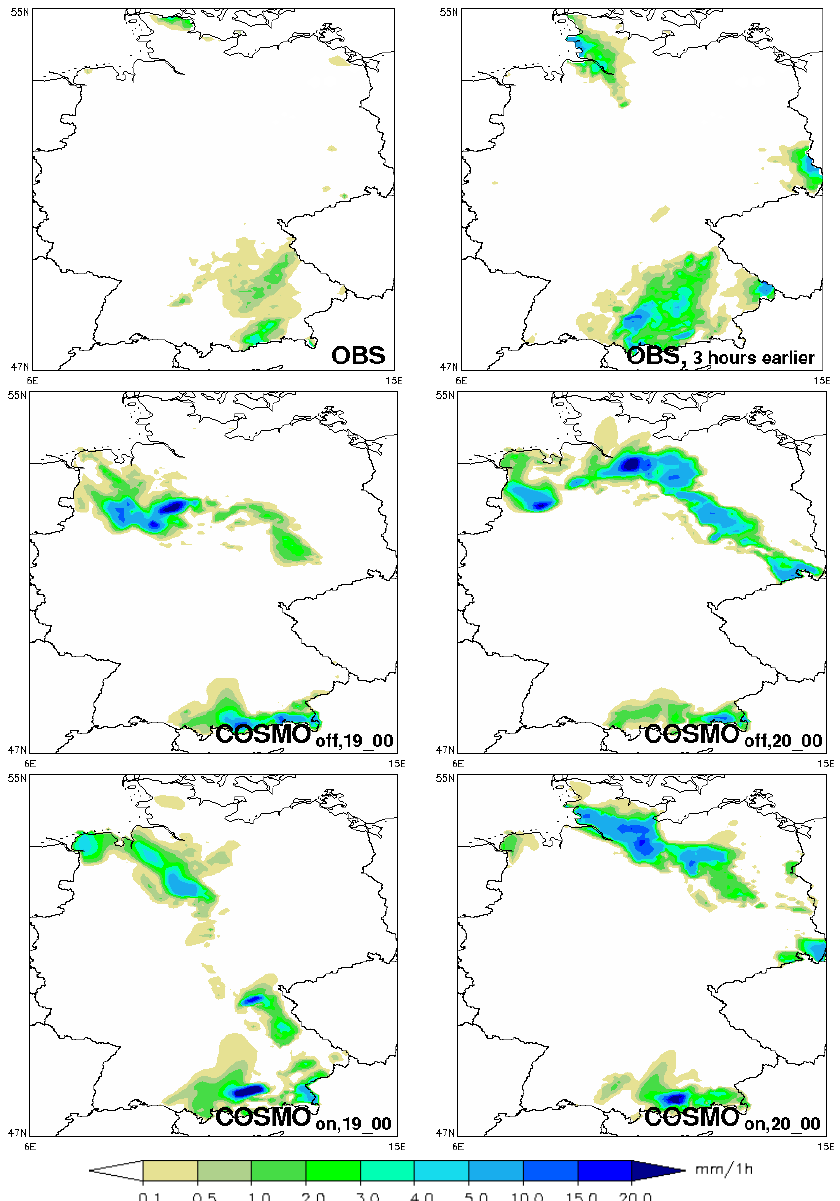
Fig. 10. 1h-accumulated precipitation for 23:00 UTC 20 July to 00:00 UTC 21 July 2007 for different simulations and an observational data set (top left panel). In addition, the top right panel shows the observed 1h-accumulated precipitation for 20:00–21:00 UTC 20 July. Fig. 8 appears delayed and not as strong as observed, because the frontal convection already starts